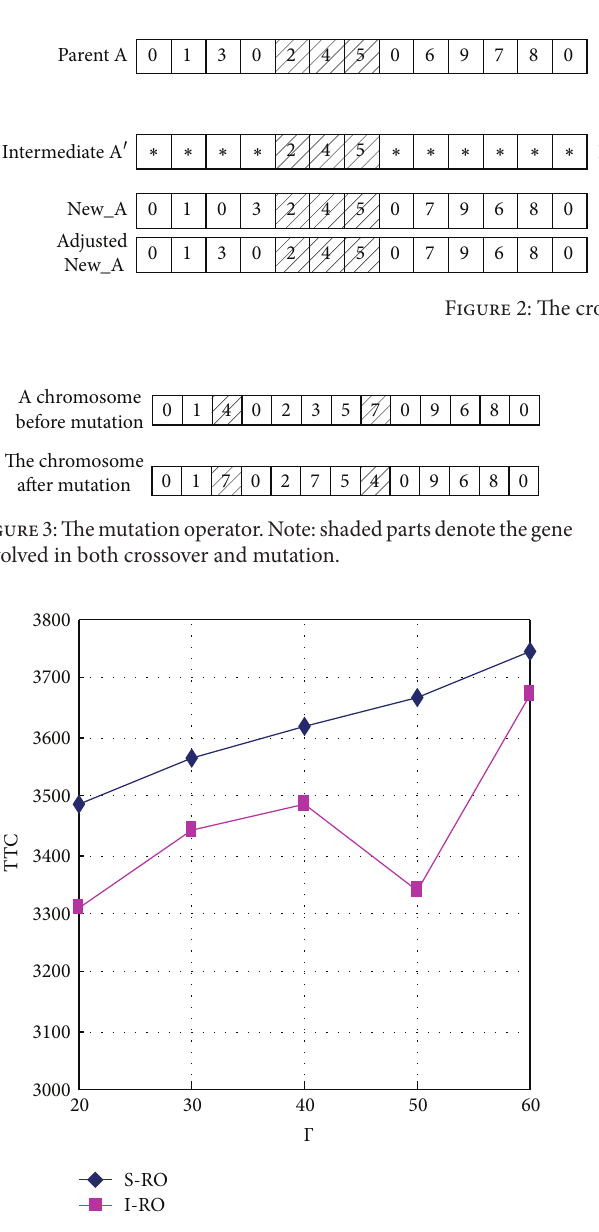
Figure 4: Variation in TTC for different Γ values.